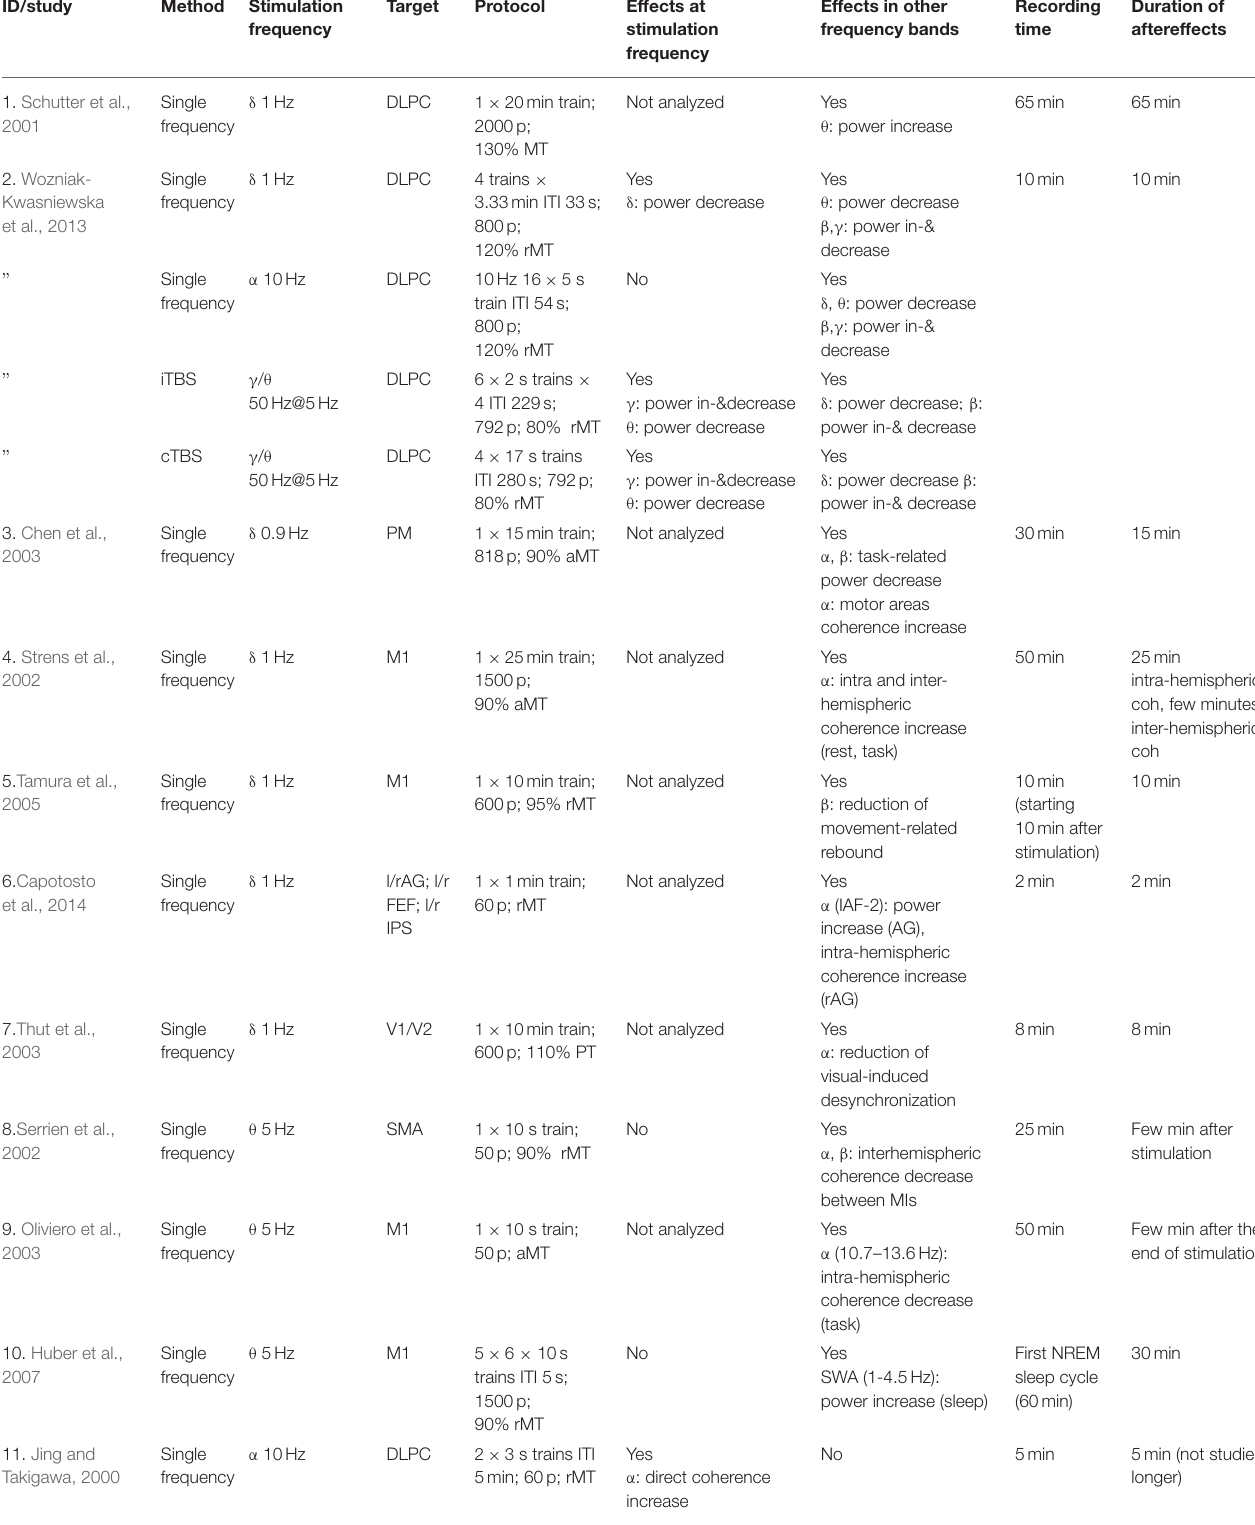
TABLE 2 | Aftereffects of repetitive (also called rhythmic) transcranial magnetic stimulation (rTMS) as assessed by EEG/MEG.